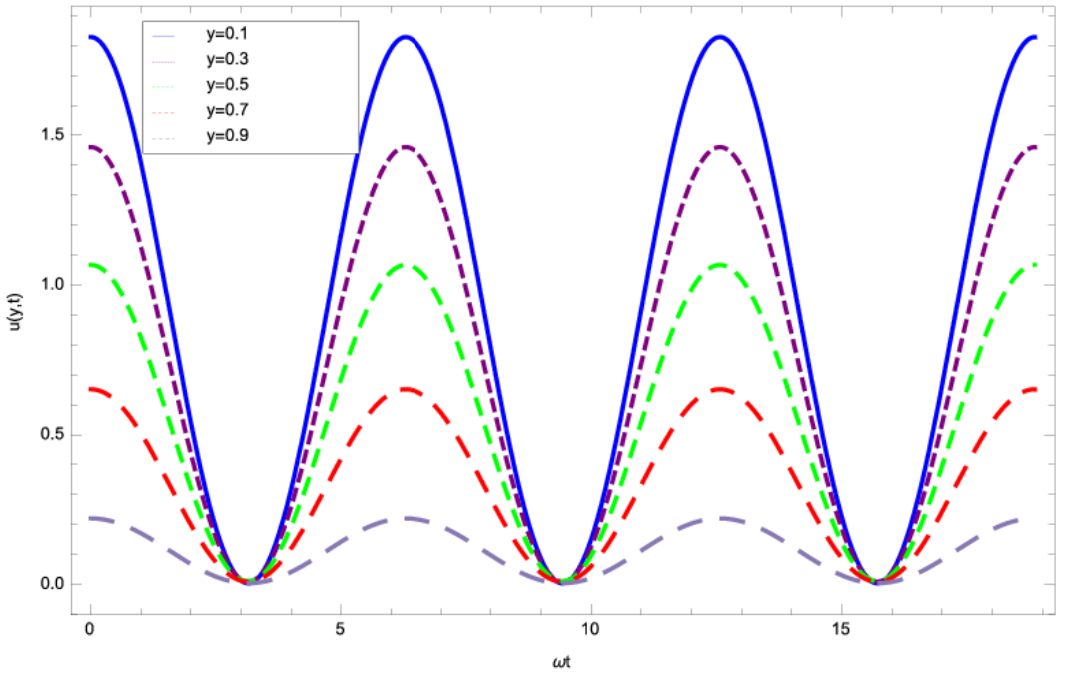
Figure 4. The view of the fluid motion at time level ω t ∈ ( − 3 π ,3 π ) in 2D, when m = 0.3, M = 0.2, W e = 0.1 0 . 3 ,